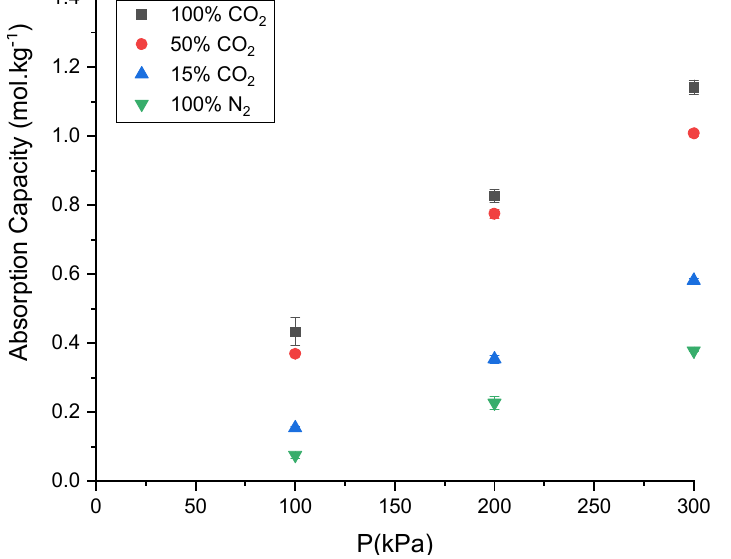
Figure 17. Absorption capacity of ChCl:LvAc (1:3:2.5) for different gas mixtures of CO 2 and N 2 . Experiments carried out at 25 °C and 250 rpm.